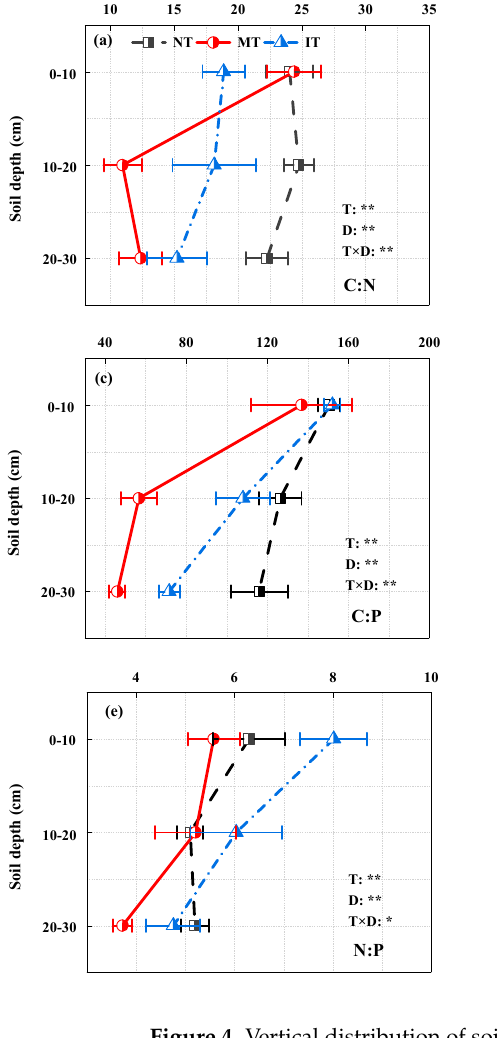
Figure 4. Vertical distribution of soil C:N ( a , b ), C:P ( c , d ), and N:P ( e , f ) (mean ± SD, n = 3) stoichiometry in the 0–30 cm soil profile in the no-thinning control (NT), moderate thinning (MT), and heavy thinning (IT), respectively. Significant differences between thinning treatments (T), soil depths (D), and their interactions are shown at *, p < 0.05; **, p < 0.01. Different capital letters (A, B, and C) indicate significant differences between the same thinning treatment and different depths ( p < 0.05); different capital (D, E, and F) and lowercase letters (a, b, and c) indicate significant differences among different thinning treatments in the total soil profile (30 cm) and each 10 cm layer with corresponding soil layers ( p < 0.05), respectively. Abbreviations: C:N, SOC–to–TN ratio; C:P, SOC–to–TP ratio; N:P, soil TN–to–TP